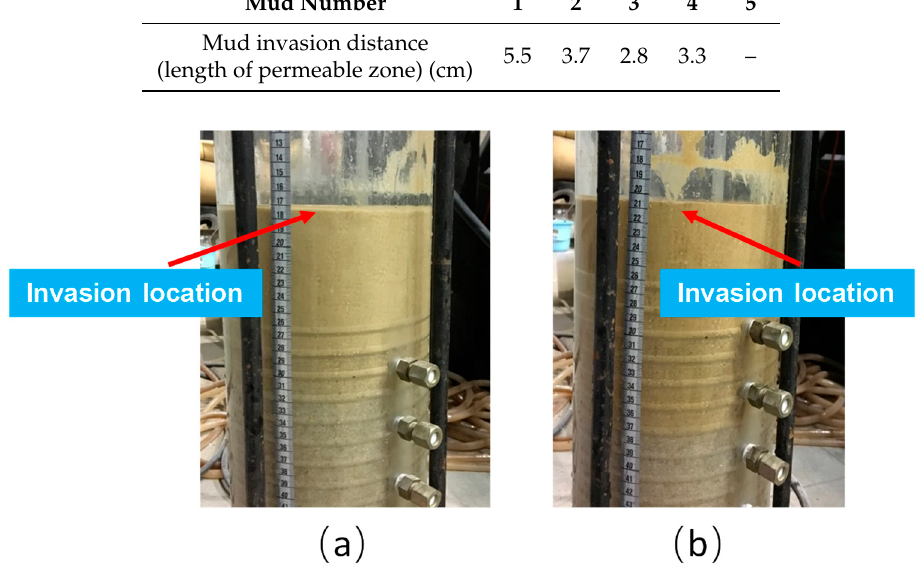
Table 3. Mud invasion distance (thickness of permeable zone).